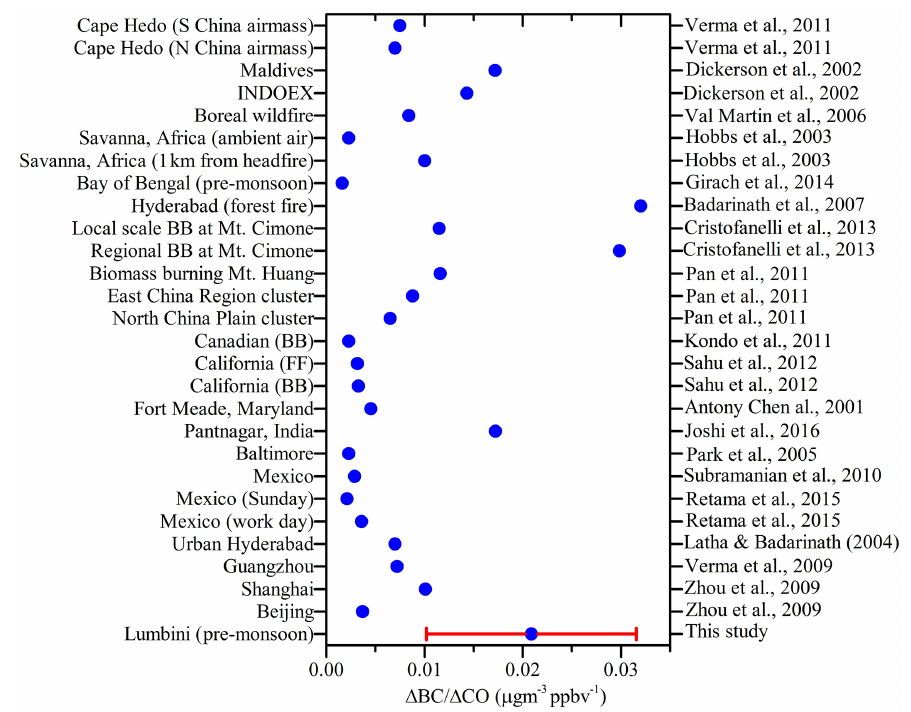
Figure 4. Comparison of black carbon concentrations to CO concentrations ( (cid:49) BC /(cid:49) CO) ratios obtained for Lumbini with other sites. The red horizontal bar represents